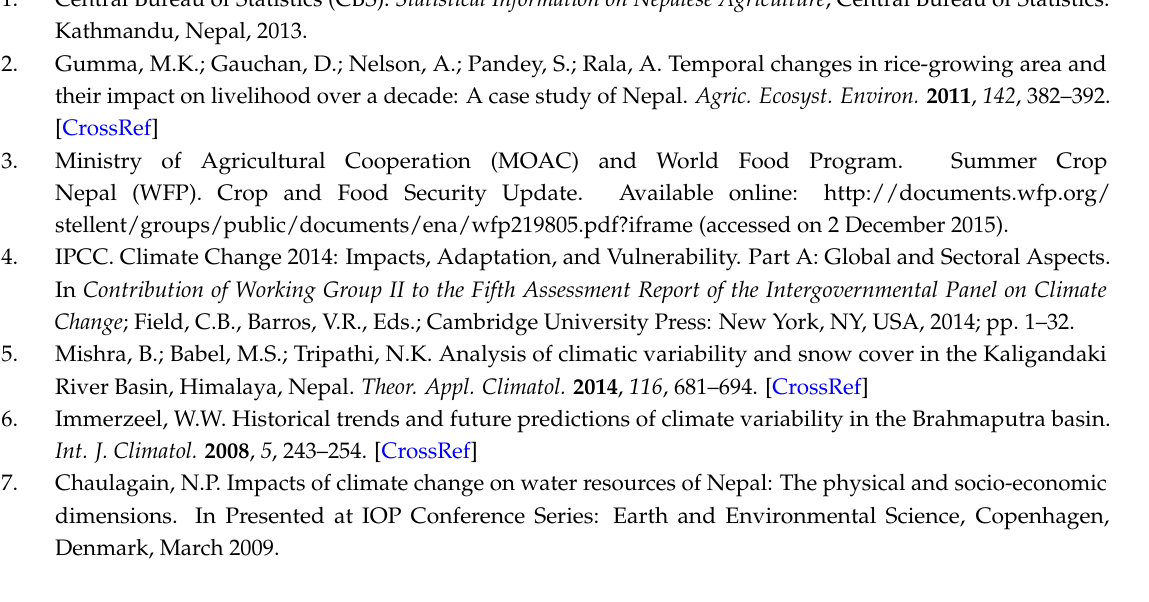
Ministry of Agricultural Cooperation (MOAC) and World Food Program. Summer Crop Nepal (WFP). Crop and Food Security